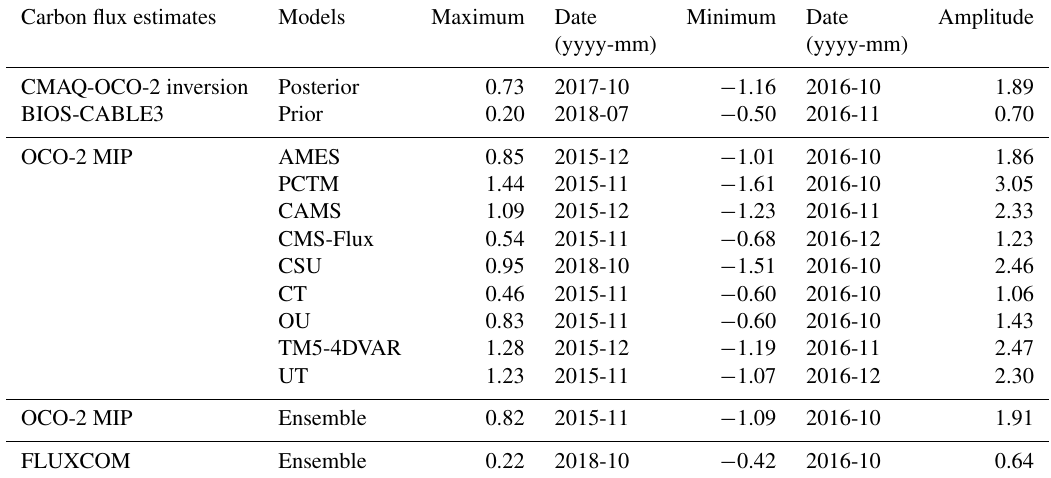
Table 3. Summary of the peak-to-peak amplitude of 3-month running mean posterior, prior, and FLUXCOM flux anomalies as well as 3-month running mean anomalies of the nine different models from OCO-2 MIP (in PgCyr − 1